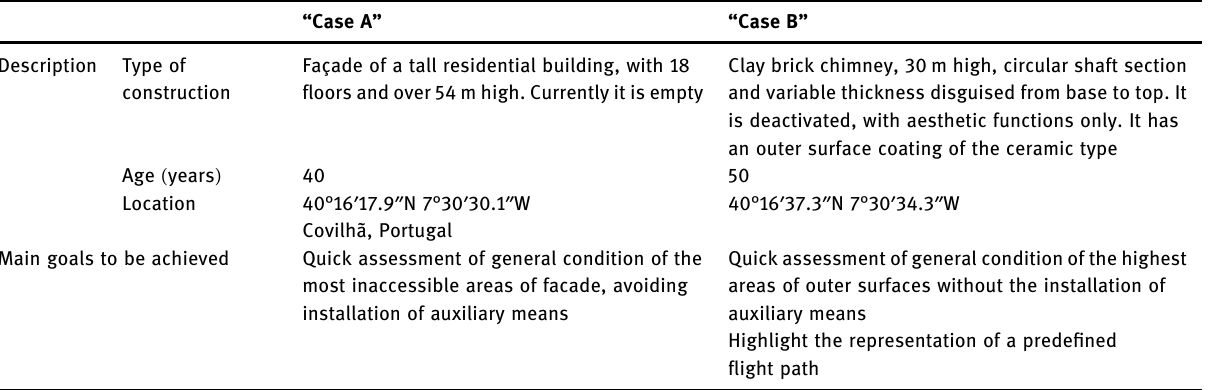
Table 2: Description of case studies “ Case A ” “ Case B ” Description Type of